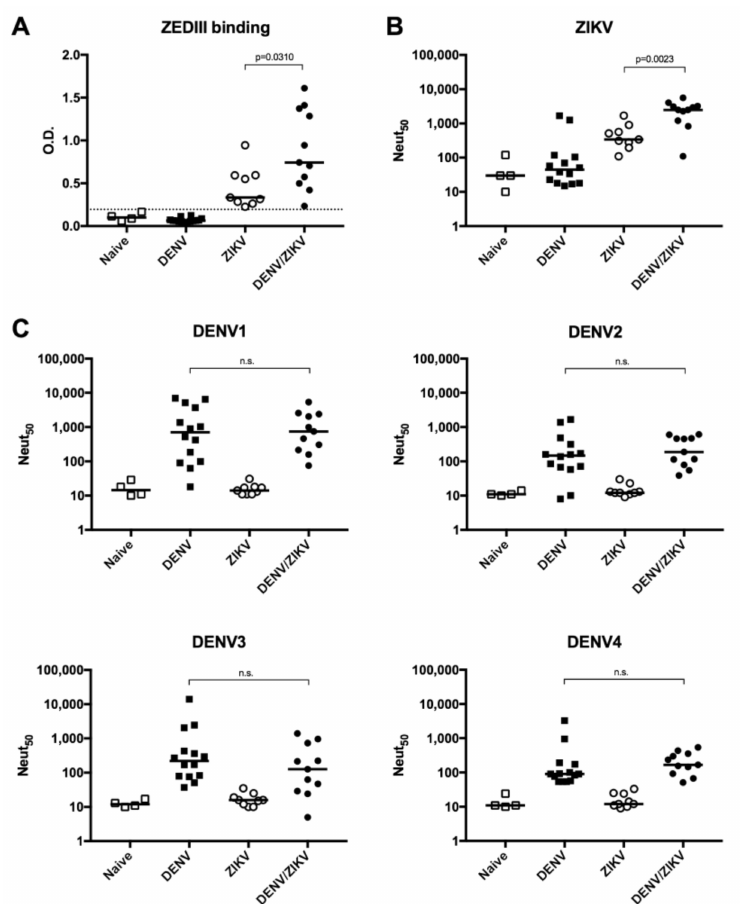
Figure 3. Analysis of ZIKV EDIII (ZEDIII)-binding and ZIKV- and DENV-neutralizing activity of plasma samples from DENV- and/or ZIKV-immune donors. ( A ) Detection of ZEDIII-binding antibodies by ELISA; ( B ) quantification of neutralizing activity against ZIKV; ( C ) quantification of neutralizing activity against DENV1, 2, 3, and 4. Naïve: plasma samples from naïve donors; DENV: plasma samples from DENV-immune ZIKV-naïve donors; ZIKV: plasma samples from ZIKV-immune DENV-naïve donors; DENV/ZIKV: plasma samples from DENV-immune ZIKV-immune donors. Each dot represents one donor and the bars represent the median value for each group of donors. The p values were calculated using the nonparametric two-tailed Mann–Whitney test; n.s.: not significant. The dotted line represents the ELISA cut-off